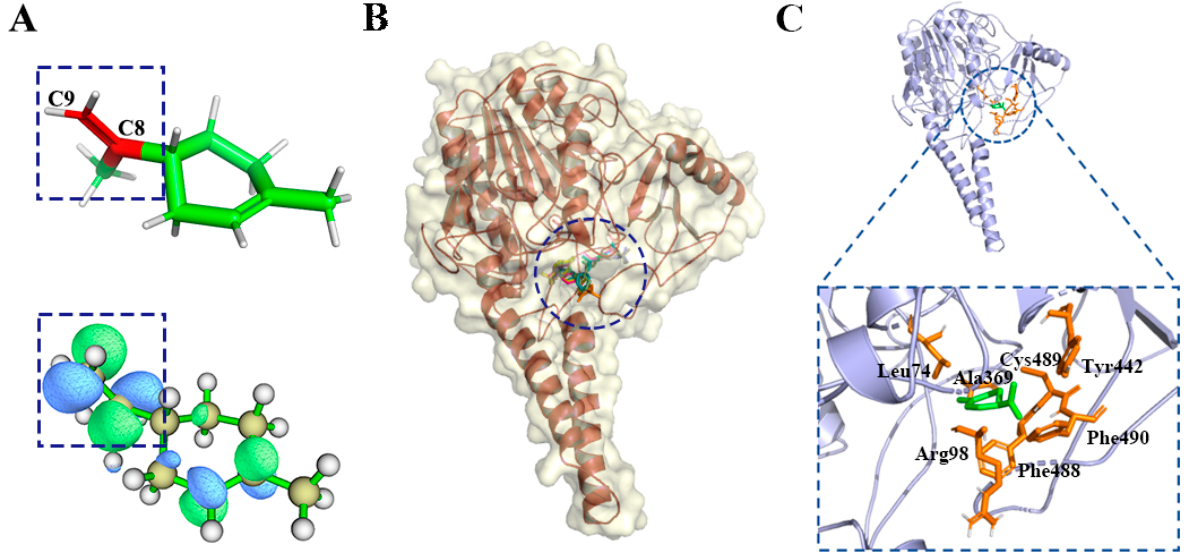
Figure 3. ( A ) LUMO orbit of d-limonene. ( B ) d-limonene group compounds docking with ES. ( C ) Active residues around d-limonene docking with ES.